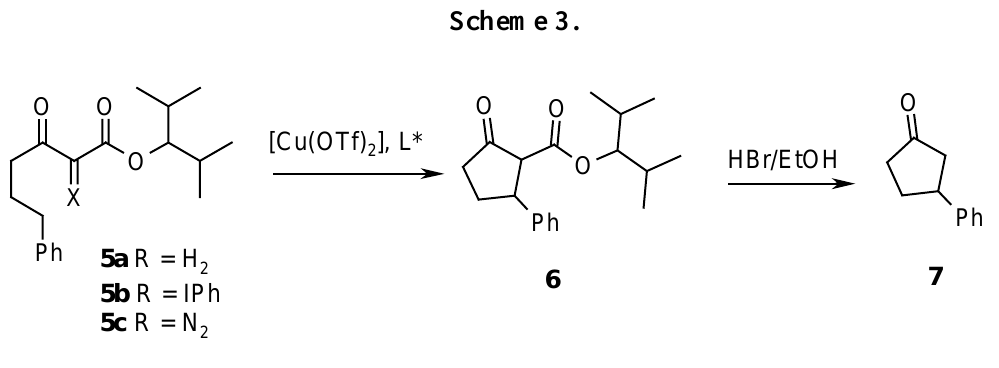
Table 1. Yields and enantioselectivities in intramolecular CH insertions